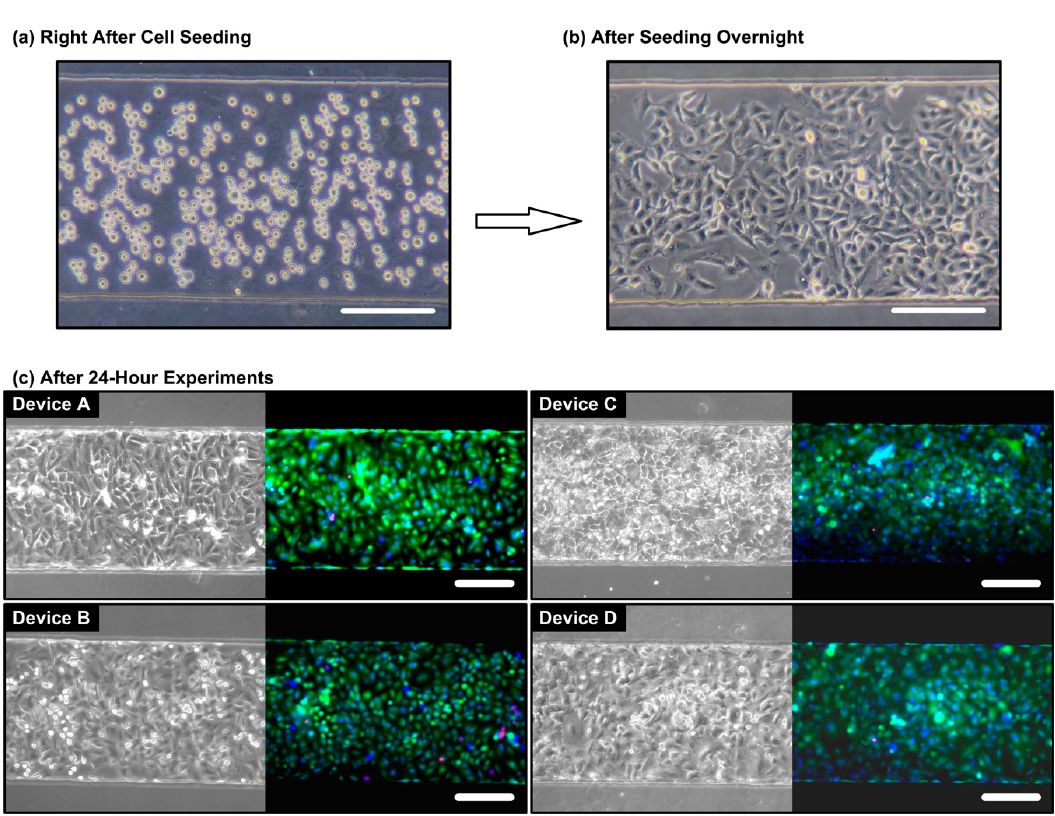
Figure 4. The microscopic images of the A549 cells ( a ) right after seeding into the microfluidic device, and ( b ) after culturing in the microfluidic device overnight. After the overnight culture, the A549 cells attach well onto the cell culture chamber substrate. ( c ) Bright field phase and live (green)/dead (red)/nuclei (blue) fluorescence images of the A549 cells inside the culture chamber after 24-h cell experiments under the 4 different conditions. Device A: control experiment in the growth medium; Device B: cell culture in the growth medium containing 1 μ M dexamethasone; Device C: cell culture in the growth medium with the physical stimulations; and Device D: cell culture under the combination of dexamethasone treatment and physical stimulations. The scale bars are 200 μ m.